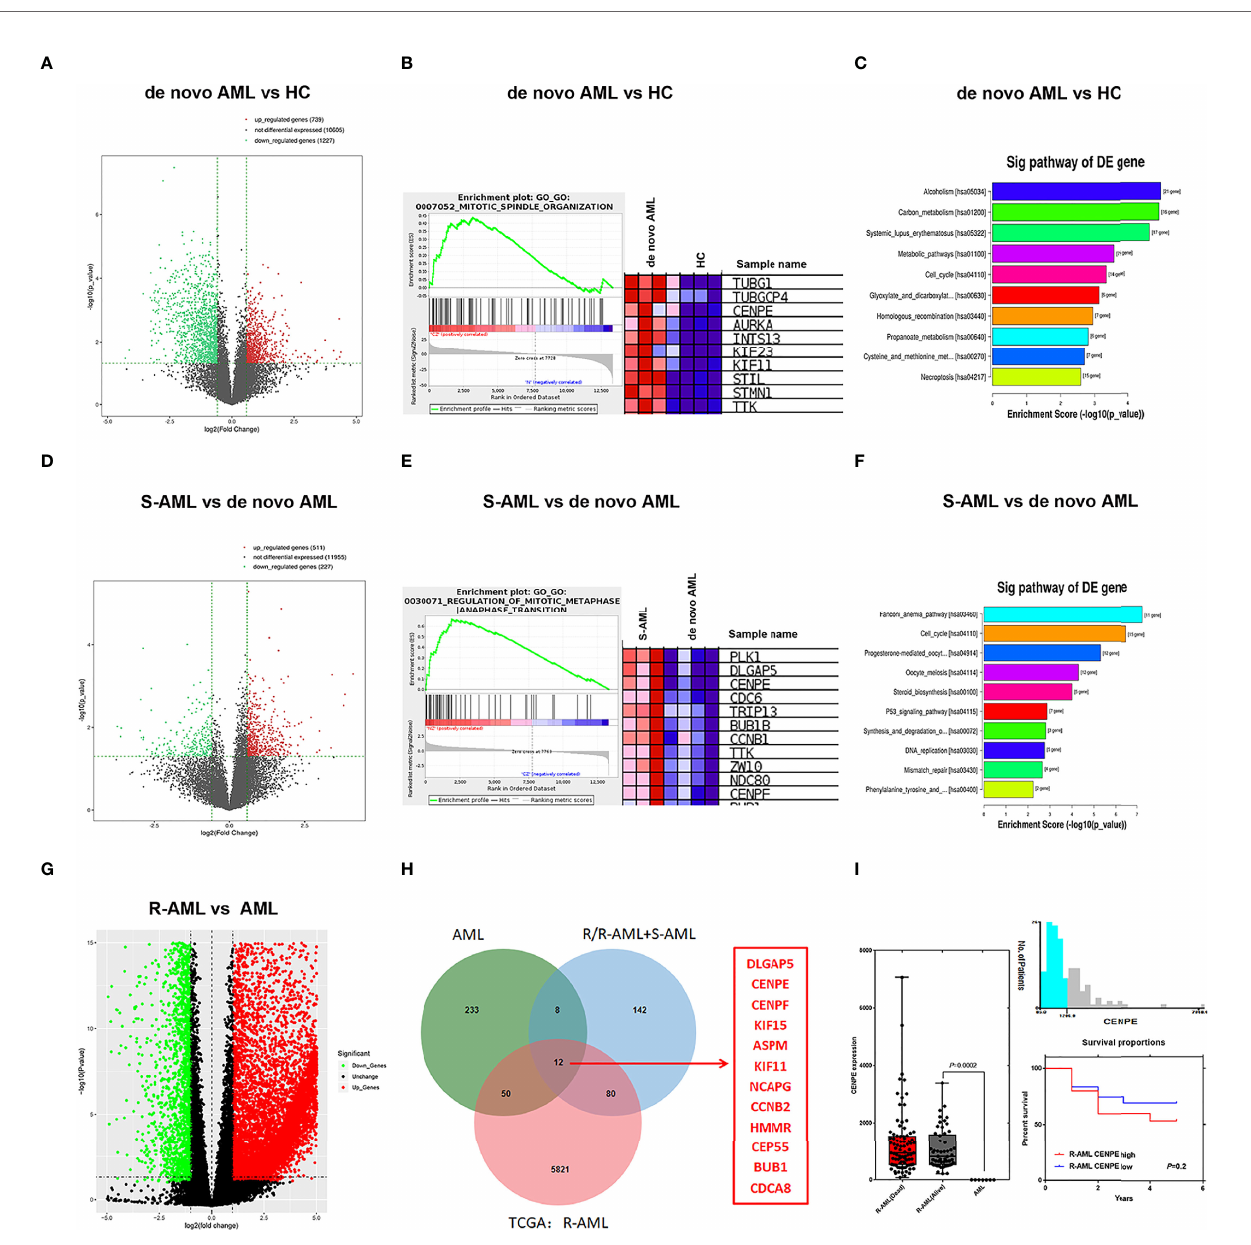
FIGURE 1 | Mitosis-related gene CENPE was highly expressed in chemoresistance AML patients. (A) DEGs in de novo AML patients compared with HC. (B) GSEA enrichment plots of DEGs of GO biological processes were predominantly engaged in mitotic spindle organization (GO:0007052) in de novo AML patients compared with HC. (C) Upregulated DEGs enriched KEGG pathways in de novo AML patients compared with HC. (D) DEGs in S-AML versus de novo AML patients. (E) GSEA enrichment plots of DEGs of GO biological processes were predominantly engaged in regulation of mitotic metaphase/anaphase transition (GO:0030071) in S-AML versus de novo AML patients. (F) Upregulated DEGs enriched KEGG pathways in S-AML versus de novo AML patients. (G) The DEGs in R-AML from TCGA versus primary AML from GEO. (H) Twelve targeted upregulated DEGs among R/R-AML, S-AML, R-AML, and primary/ de novo AML patients. (I) CENPE in R-AML was signi fi cantly higher than that of primary AML patients. X-tile software calculated the cutoff values of CENPE in R-AML patients, and survival analysis was conducted in R-AML patients with CENPE high expression and R-AML patients with CENPE low